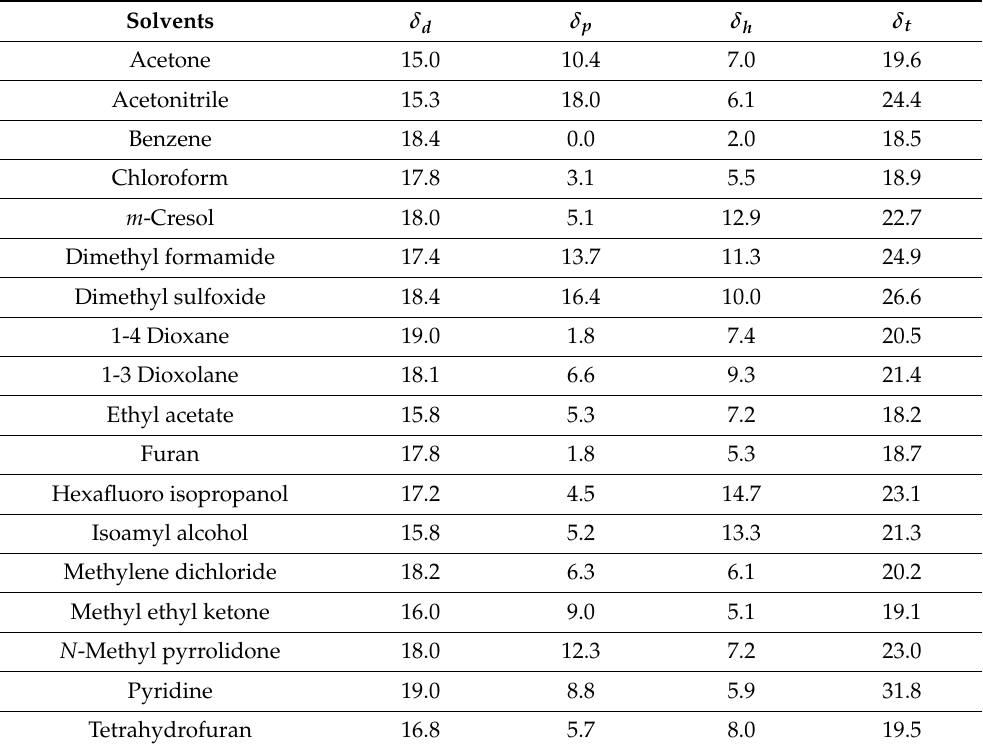
Table 11. Solubility parameters of key solvents at 25 ◦ C